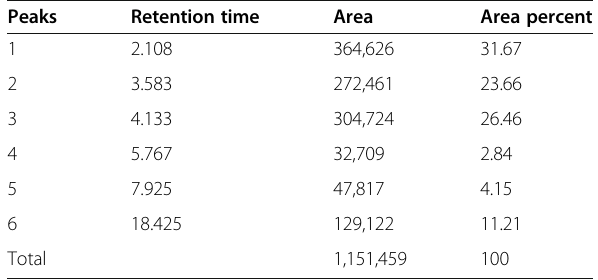
Table 3 Retention factors of hydrolysed EPS of L. paraplantarum KM1 from HPLC Peaks